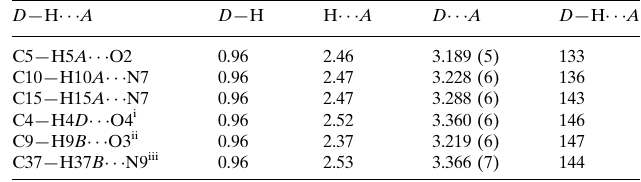
Hydrogen-bond geometry (A˚ , (cid:3)